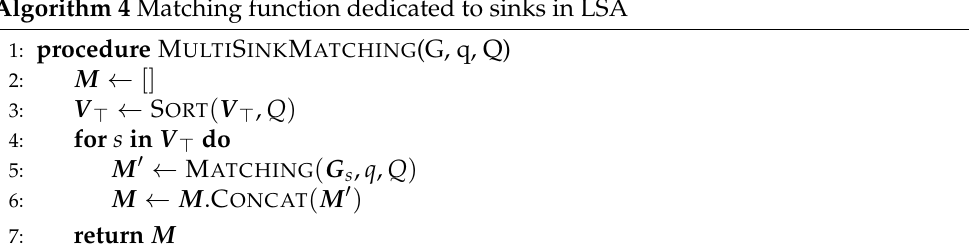
Algorithm 4 Matching function dedicated to sinks in